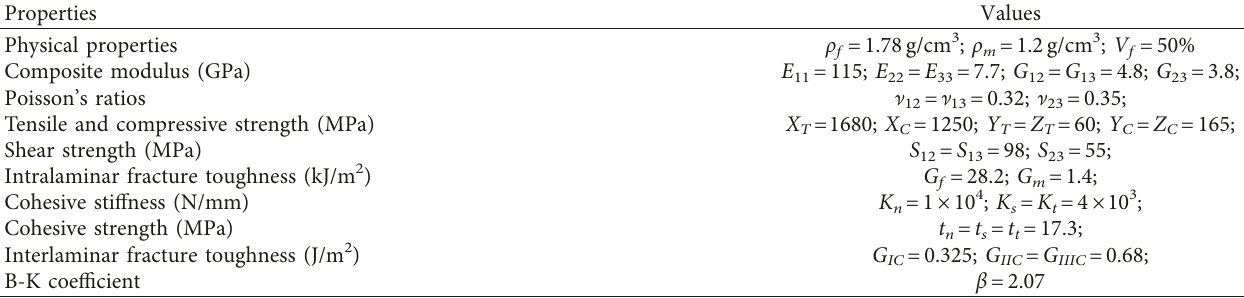
Table 1: Input material properties for carbon fibre/epoxy composite ply.